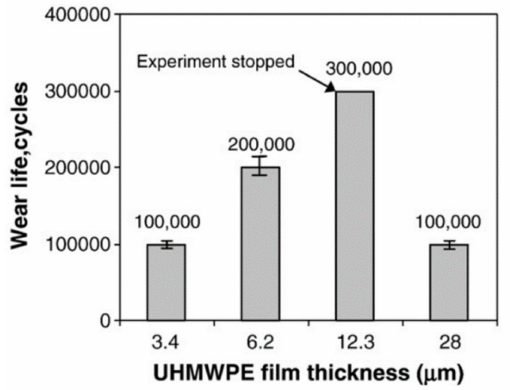
Figure 4. Wear life for different UHMWPE thicknesses for Si/DLC/UHMWPE. Data are averages of three repeated tests. For 12.3 µ m thick film there was no failure at 300,000 cycles of sliding when the experiments were stopped due to long test duration [54]. Reproduced with permission from